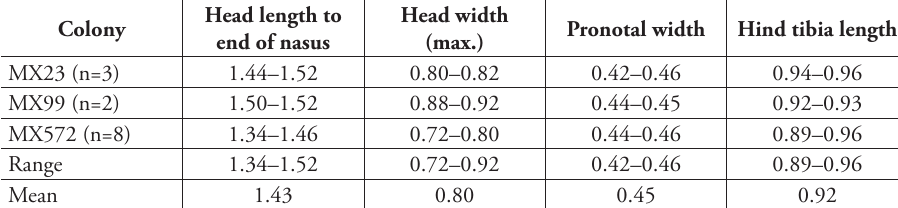
Table 1. Measurements (mm) of Parvitermes mexicanus comb. n. soldiers. Colony